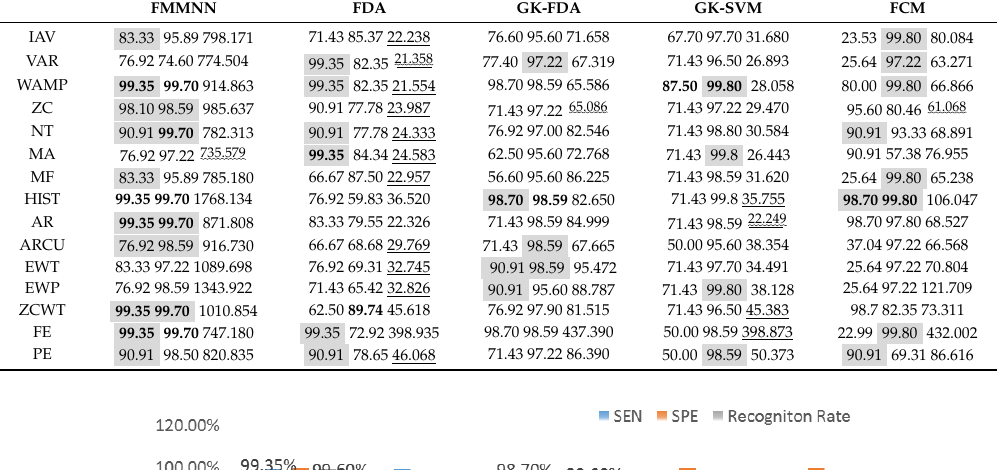
Figure 9. Sensitivity (SEN) and specificity (SPE). ( a ) Average sensitivity (error bar: standard error), ( b ) Average specificity (error bar: standard error).